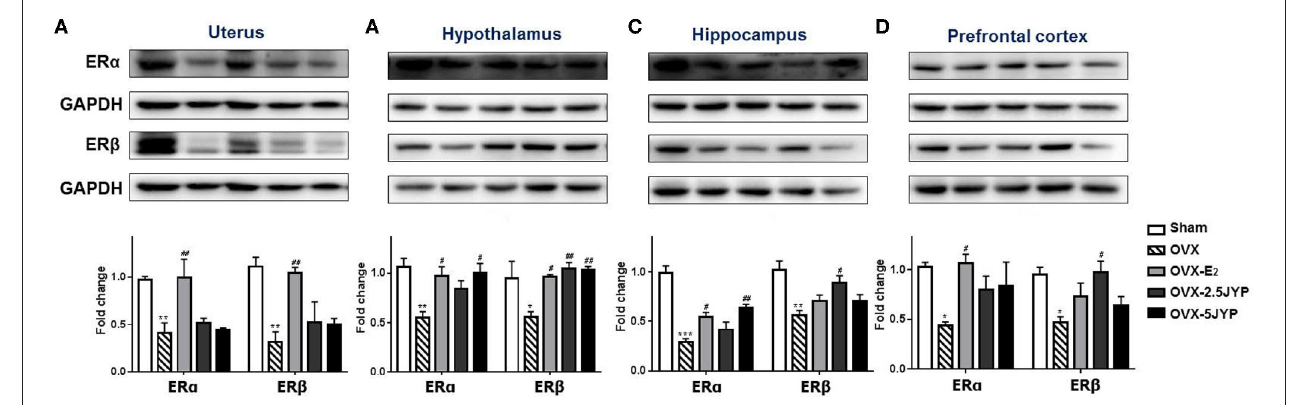
FIGURE 10 | Effects of 2.5 g/kg JYP (2.5 JYP), 5.0 g/kg JYP (5 JYP), and 0.3 mg/kg estradiol (E2) on the expression of ER α and ER β in the uterus (A) , hypothalamus (B) , hippocampus (C) , and prefrontal cortex (D) . Data are expressed as mean ± SEM ( n = 3) and examined with one-way analysis of variance (ANOVA), followed by post hoc between-group comparisons: * P < 0.05, ** P < 0.01, *** P < 0.001 vs. sham group; # P < 0.05, ## P < 0.01, vs. vehicle